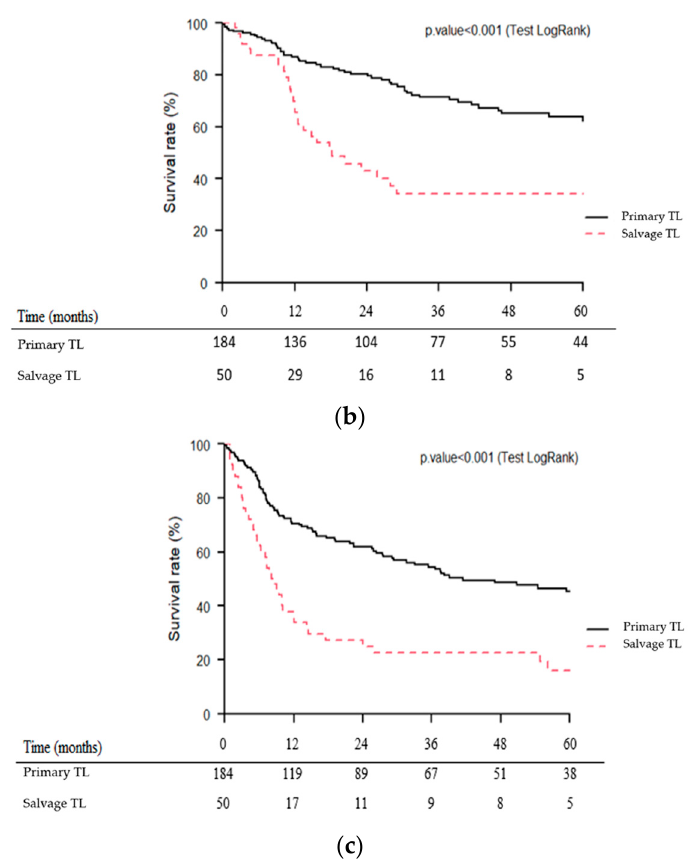
Figure 2. Kaplan–Meier overall ( a ), cause-specific ( b ) and recurrence-free ( c ) survival curves for patients undergoing primary vs. salvage total laryngectomy (TL).